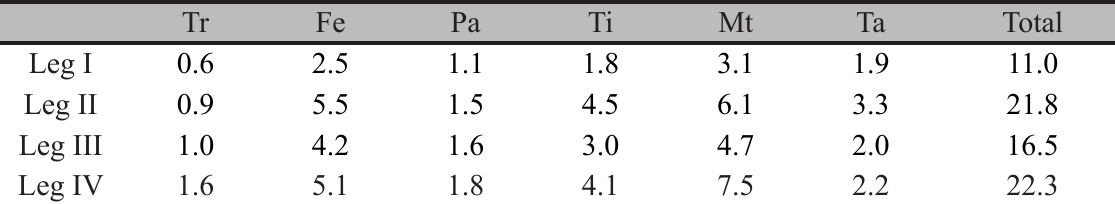
Table 5. Leg measurements (in mm) of Amazochroma pedroi gen. et sp. nov., ♂, holotype (MNRJ